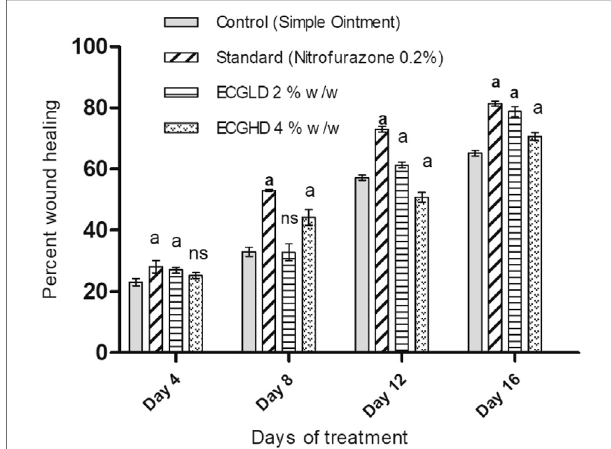
ECGLD:extract of C. gigantea lowdose;ECGHD: extractof C. gigantea highdose. n (cid:2) 6 animalsin eachgroup.The treatedgroups are analyzedbytwo-way ANOVAfor woundclosure and -way ANOVA for the period of epithelization by comparing with the control group. ***p < 0.001, ns: not signi fi cant.